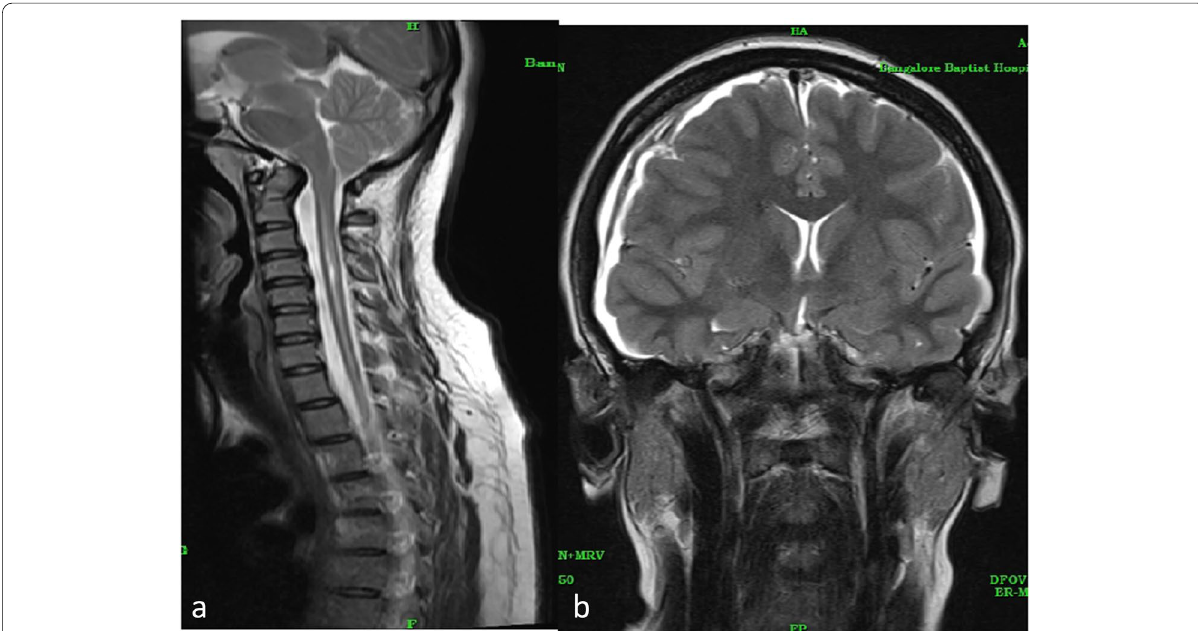
Fig. 2 a Low-lying tonsils with syringomyelia. b Bilateral subdural collections over cerebral hemispheres R>L, with hemorrhagic content, mild mass effect causing compression of ventricles, low-lying tonsils, and midline shift–3.8mm to left, suggestive of intracranial